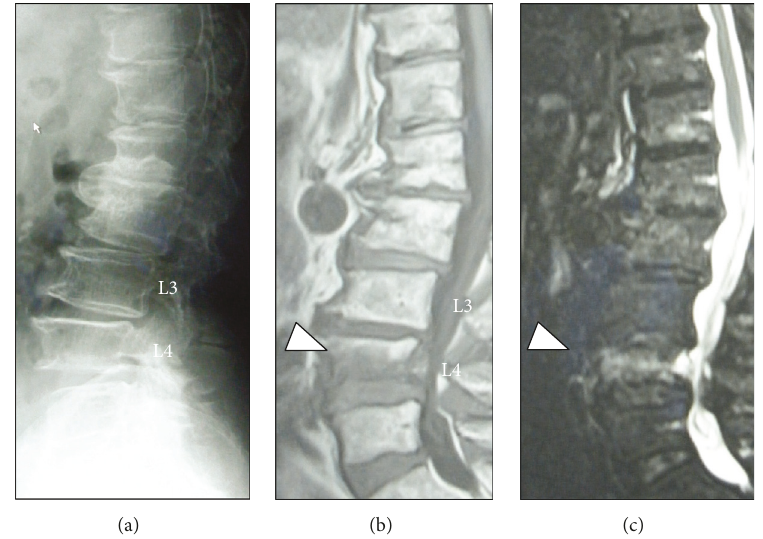
Figure 6: A 79-year-old woman with preosteoporosis ( T -score = − 2.0 SD) and a history of strain. Plain lumbar X-ray showed spondylosis with no apparent fracture (a). MRI showed a low intensity lesion in the T1-weighted image (b) with a high intensity change in the T2-STIR image (c) indicating an occult fracture at the L4 vertebral body